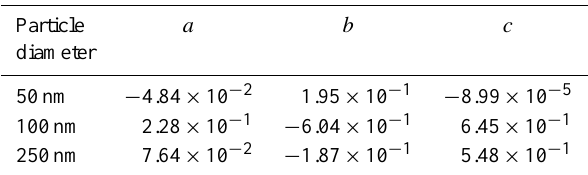
smaller particles. The fitted slopes for 100 ( r 2 = 0 . 43), 150 ( r 2 = 0 . 67), 200 ( r 2 = 0 . 70), and 250 nm ( r 2 = 0 . 55) par- ticles are 1.12, 1.26, 1.24, and 1.12, respectively, and are higher than unity. These slopes indicate, despite the